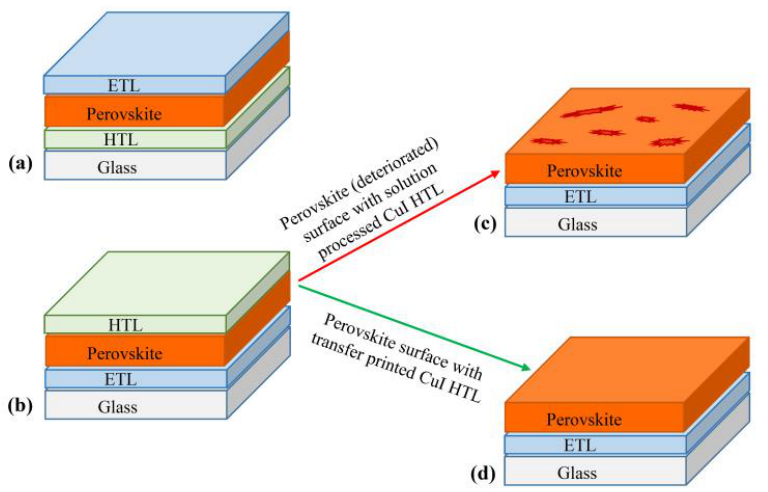
Figure 1. ( a ) p–i–n and ( b ) n–i–p structures for the perovskite solar cells. In a n–i–p structure, a perovskite surface with ( c ) solution-processed (deterioration of perovskite surface due to harmful interaction between solvents of CuI and perovskite) and ( d ) transfer-printed CuI HTLs. At the present time, spiro-OMeTAD is the most commonly used HTL in n–i–p- structured PSCs. However, the production of spiro-OMeTAD requires an ultra-low tem- perature ( − 78 ◦ C) and multiple synthesis steps, making the process complicated and highly expensive (~300 $/g) [15]. Additionally, the use of spiro-OMeTAD requires doping with lithium bis- (trifluoromethylsulfonyl)imide (Li-TFSI) and 4-tert-butylpyridine